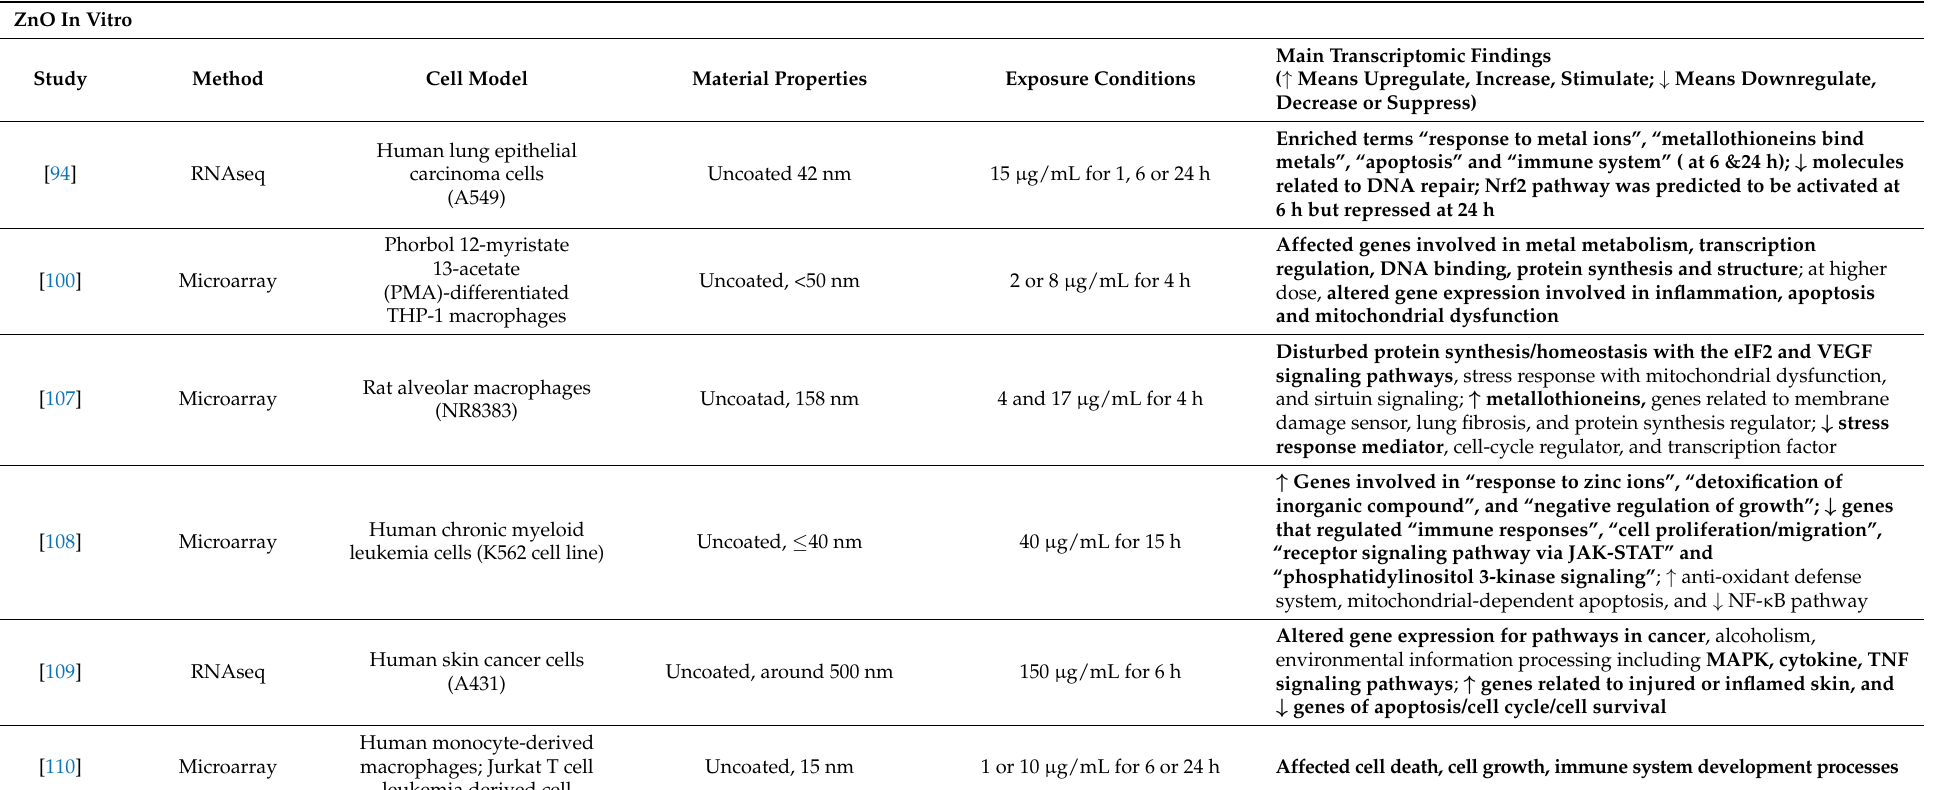
Table 1. Transcriptomic characterization of exposures to ZnO NPs in in vitro and in vivo